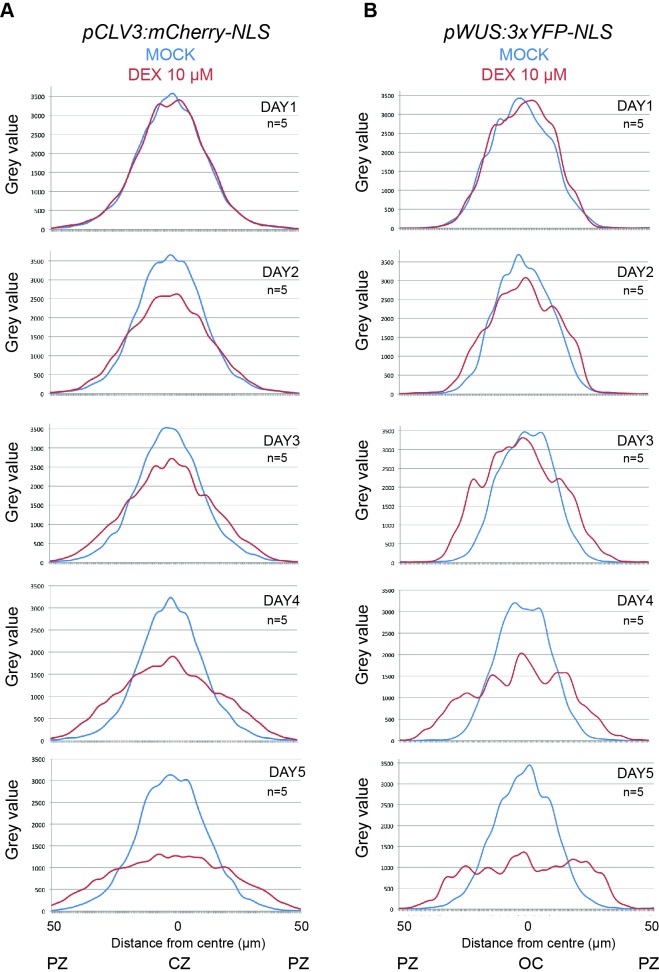
Intensity plot profiles of WUS and CLV3 reporters after HEC1-GR induction at the CZ.(A–B) Time series of intensity plot profiles in pCLV3:HEC1-linker-GR plants expressing pCLV3:mCherry-NLS and pWUS:3xYFP-NLS. The plots show the distribution of CLV3 signal (A) and WUS signal (B) in shoot meristems after mock and dex treatment.